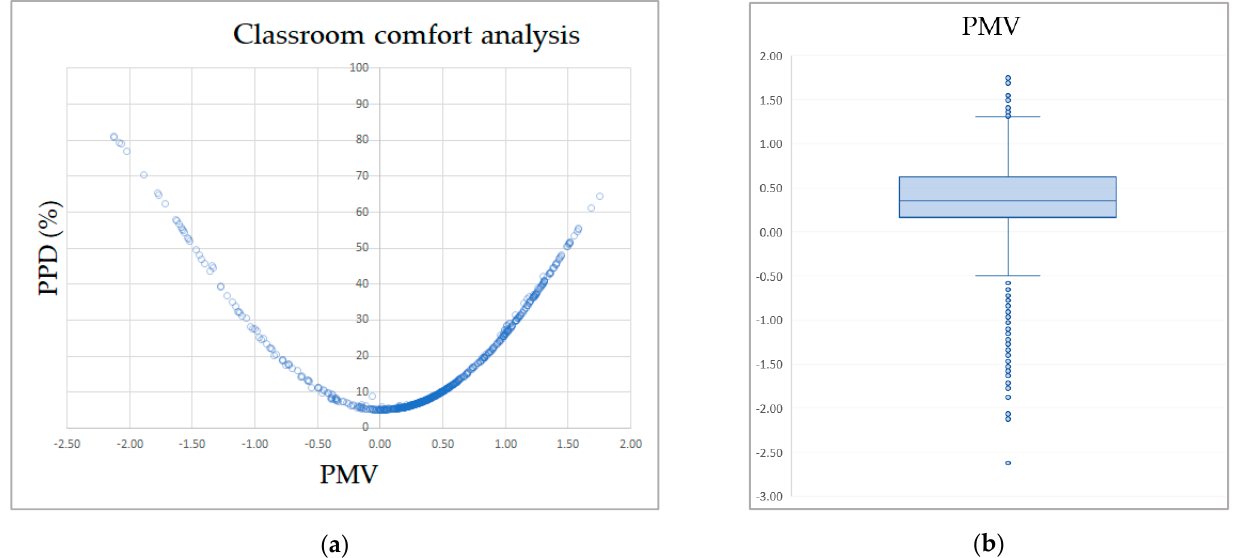
Figure 10. ( a ) Predicted mean vote (PMV) vs. predicted percentage of dissatisfied occupants (PPD%) comfort curve and ( b ) box plot for the PMV data.